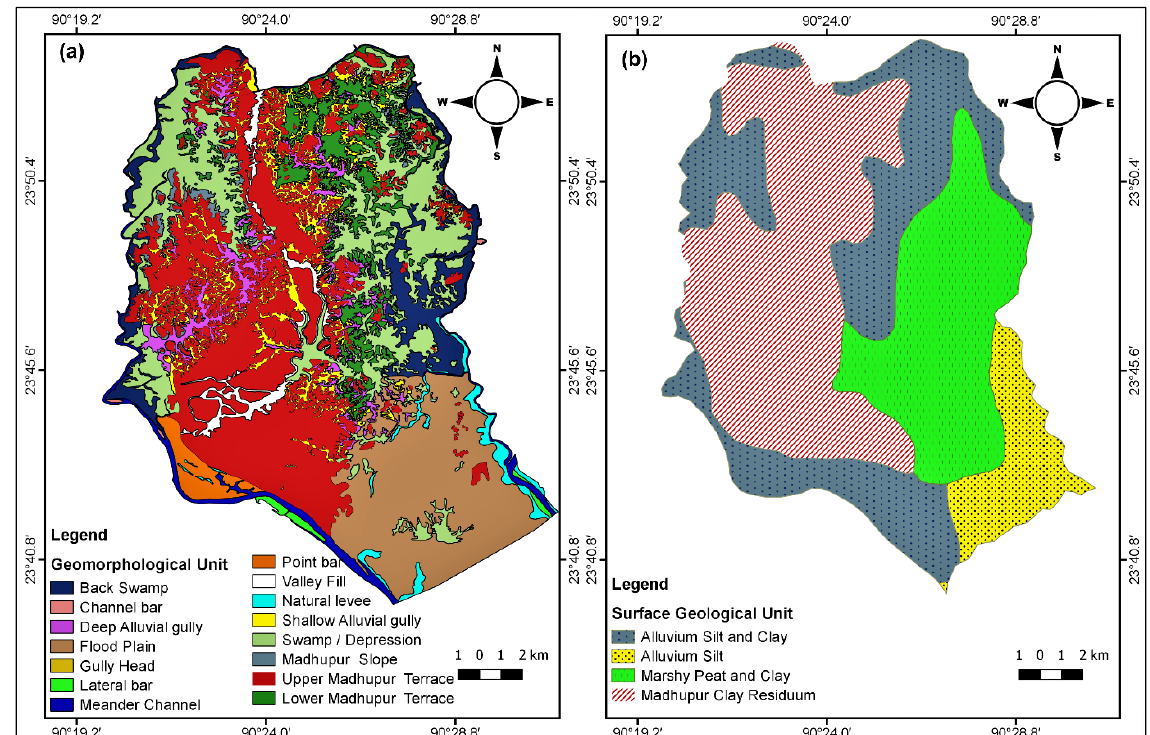
Figure 4. ( a ) Geomorphological map and ( b ) Surface geological map of Dhaka city.